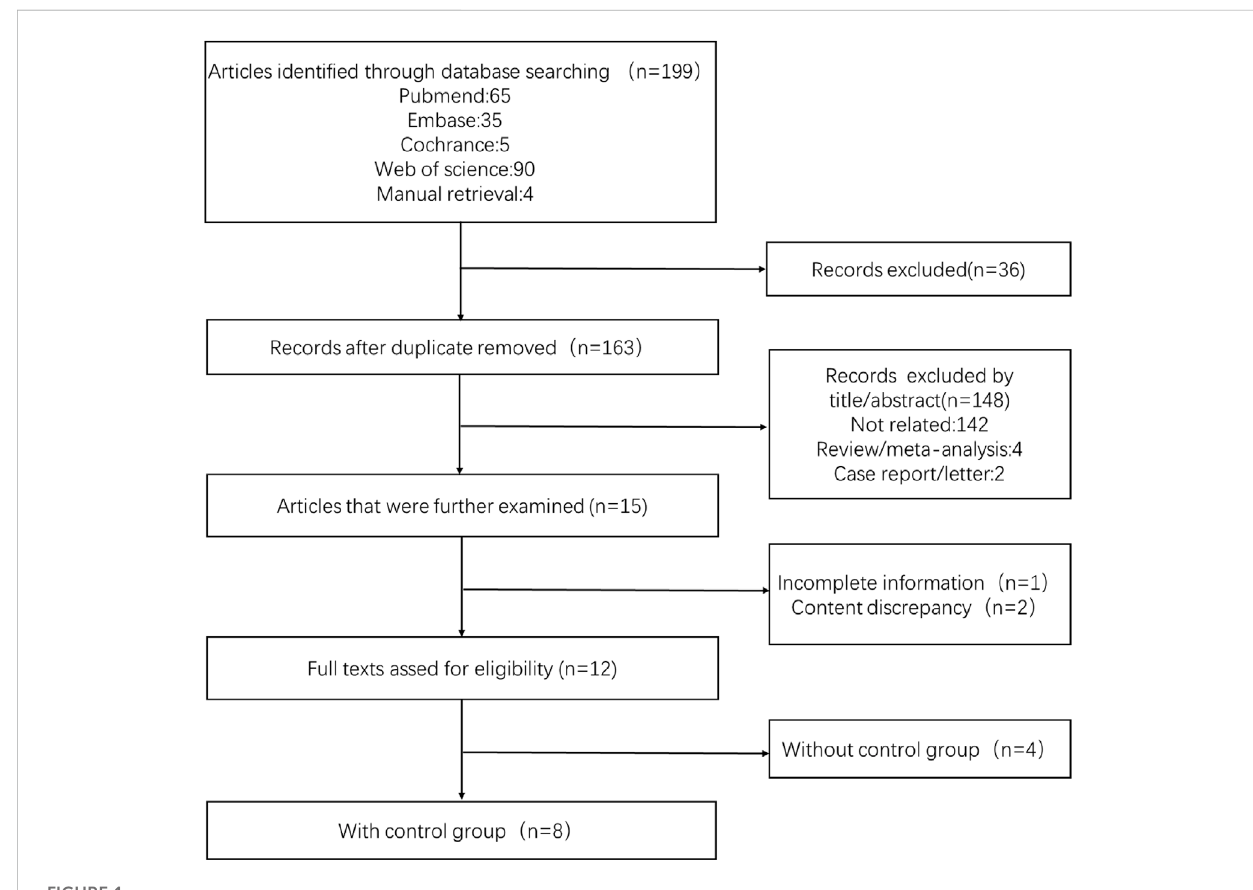
FIGURE 1 Flowchart of screening